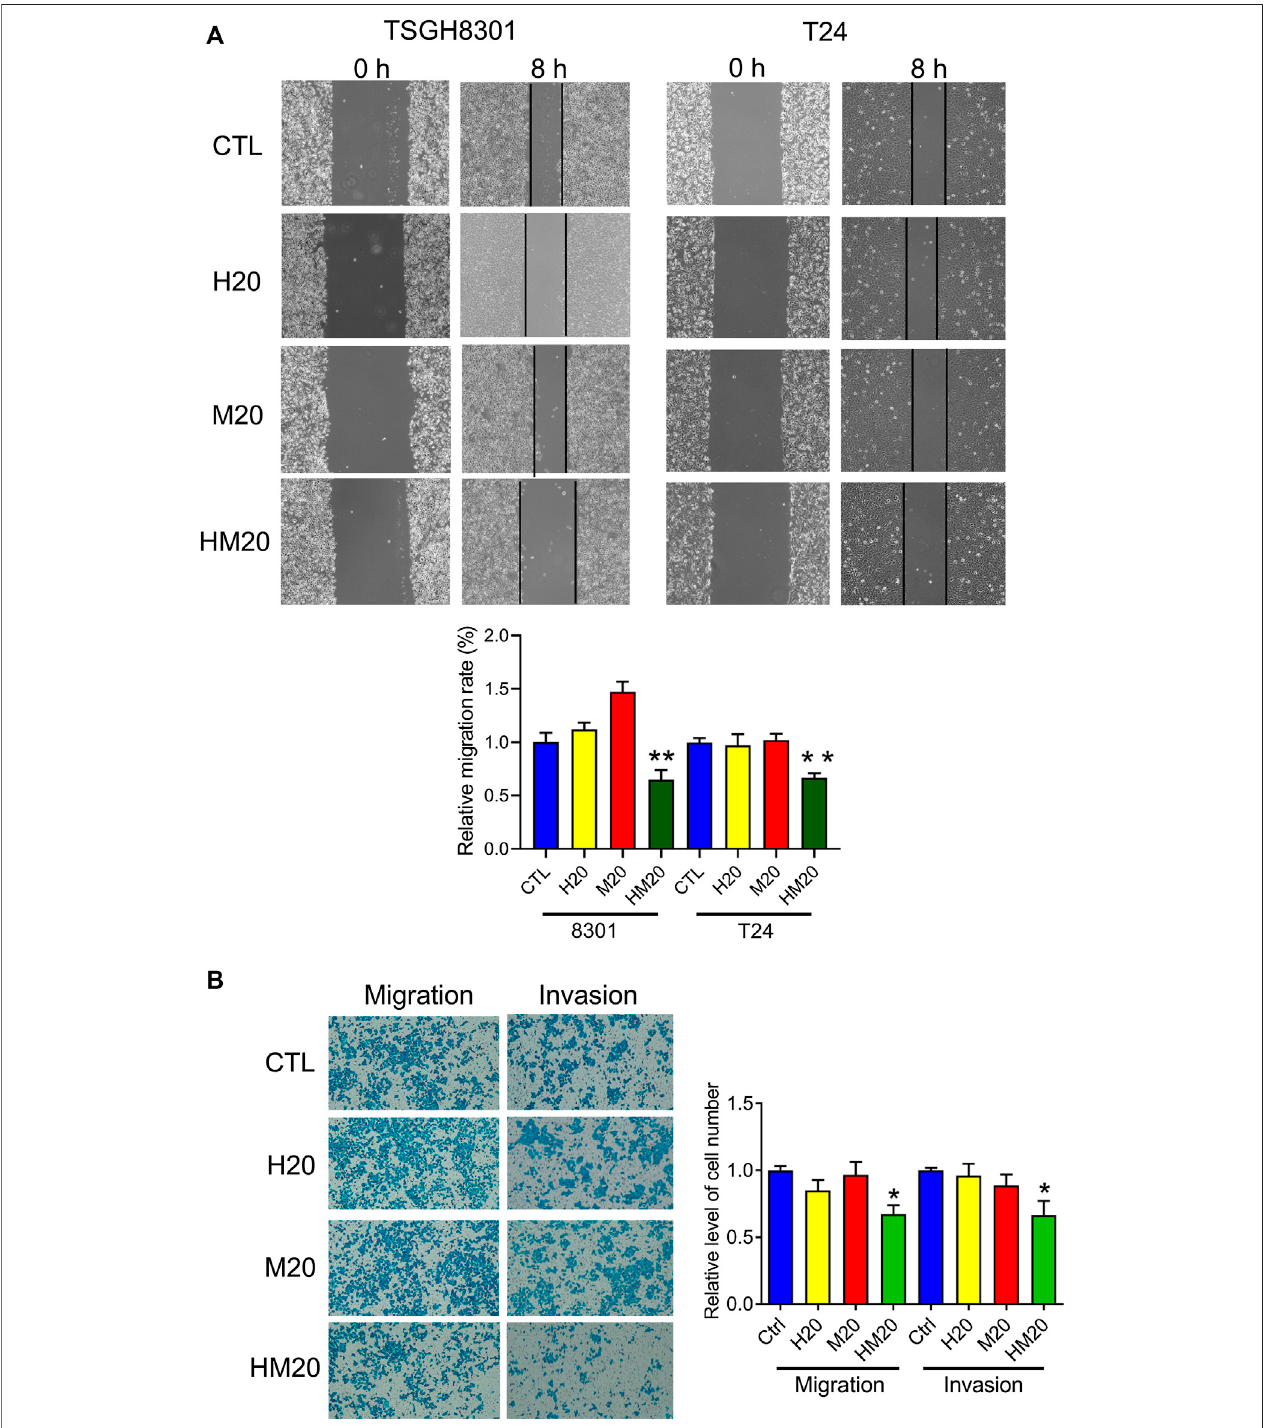
FIGURE4| Theeffect ofHono-Magoncell migration. (A) Con fl uent bladder cancercells werescratchedand incubated withHono, Mag,or Hono/Mag (20 μ M) for 8 h. The wound area was analyzed by ImageJ software and is expressed relative to that at 0 h. (B) T24 bladder cancer cells were seeded in the upper chambers of Transwells with or without Matrigel. After 24 h of incubation with Hono, Mag, or Hono/Mag (20 μ M), cells in the lower chamber were counted. * p < 0.05; ** p < 0.01 compared to the control group.